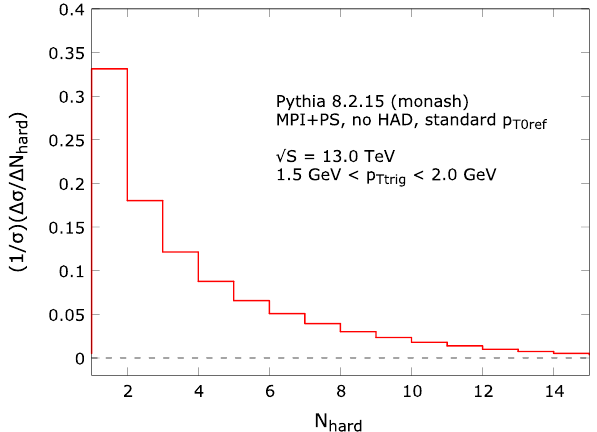
Fig. 14 Distribution of a trigger particle among the hard subsystems producedbytheMPImechanism.Thesubsystemsareorderedaccording to the p T of the hard